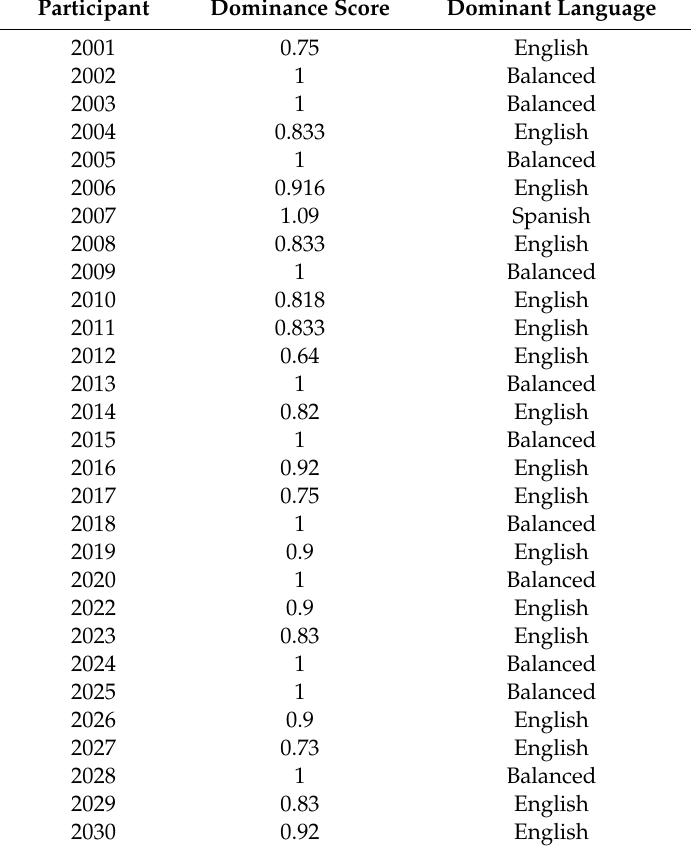
Table A3. Self-ratings of Verbal Ability individual dominance scores on a ratio of < 1 (English) to > 1 (Spanish).